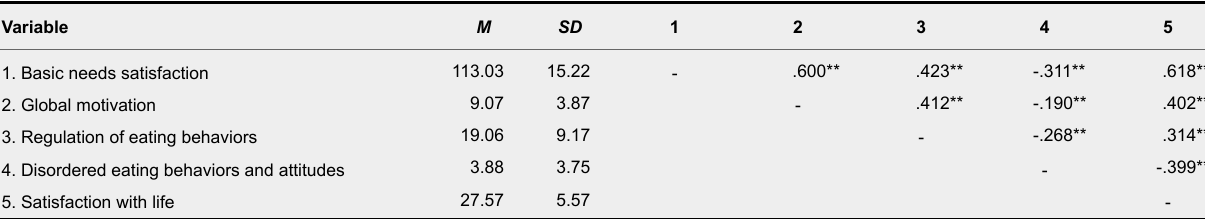
Means, Standard Deviations, and Pearson’s Correlation Coefficients for Study Variables Variable M SD 1